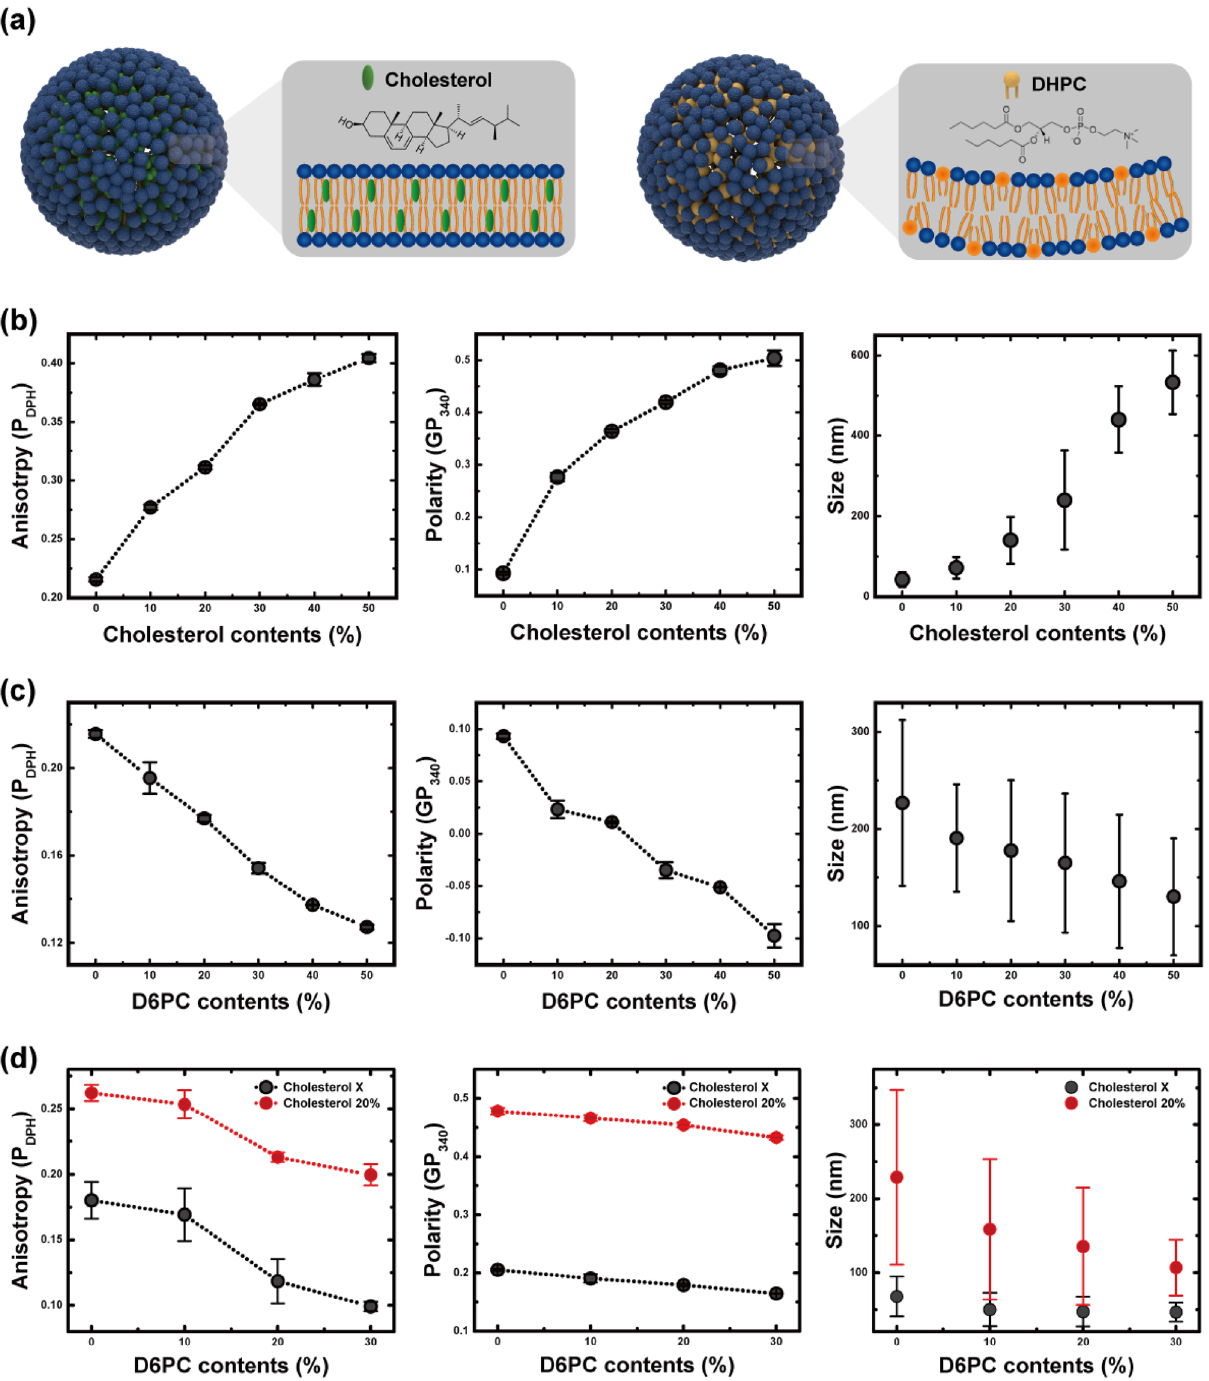
Figure 4. ( a ) Vesicle containing cholesterol and a heterogeneous vesicle containing short-chain lipids. Relationships between membrane properties (fluorescence anisotropy and polarity) and liposome size depending on ( b ) cholesterol content (flow rates of the ethanol and buffer phases fixed at 100 and 1900 µL h −1 , respectively) and ( c ) 1,2-dihexanoyl-sn-glycero-3-phosphocholine (DHPC) content (flow rates of the ethanol and buffer phases fixed at 400 and 1600 µL h −1 , respectively). ( d ) The membrane properties and size depending on DHPC contents when the ethanol content was reduced (flow rates of the ethanol and buffer phases fixed at 100 and 1900 µL h −1 ,